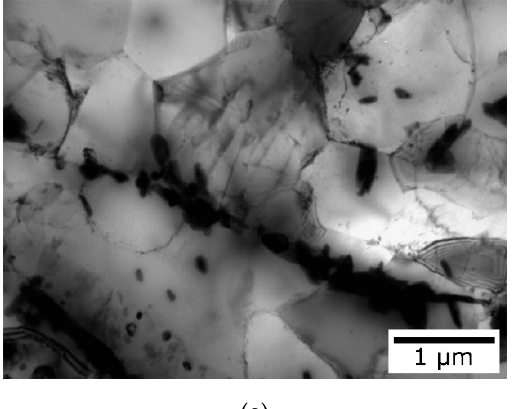
Figure 4. ( a ) Hardness (HV) and ( b ) electrical conductivity (EC) curves for EMC rod (R) and cold rolled strip (S) subjected to stepwise annealing in accordance with the processing route shown in Table 2 (see R (temperature)/S (temperature) designation).